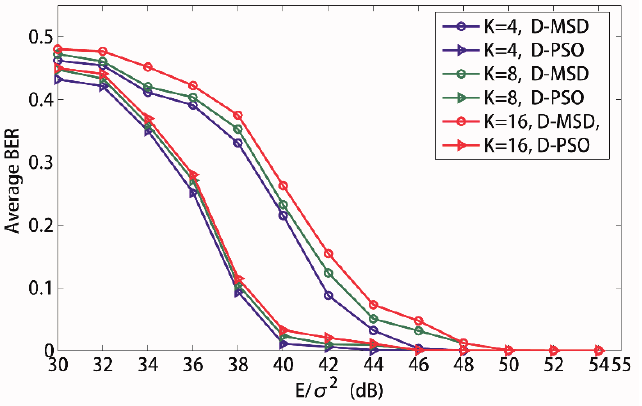
Figure 8. Influence of the number of source sensors to the average BER. K = 4, N c = 128; K = 8, N c = 256; K = 16, N c =